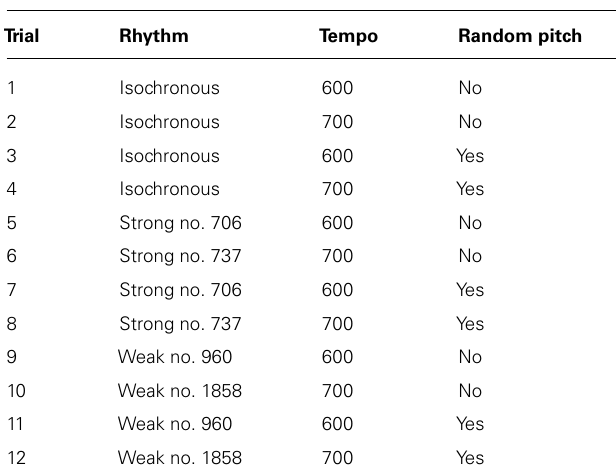
Table 1 | Characteristics of the twelve rhythms used in the synchronization tapping